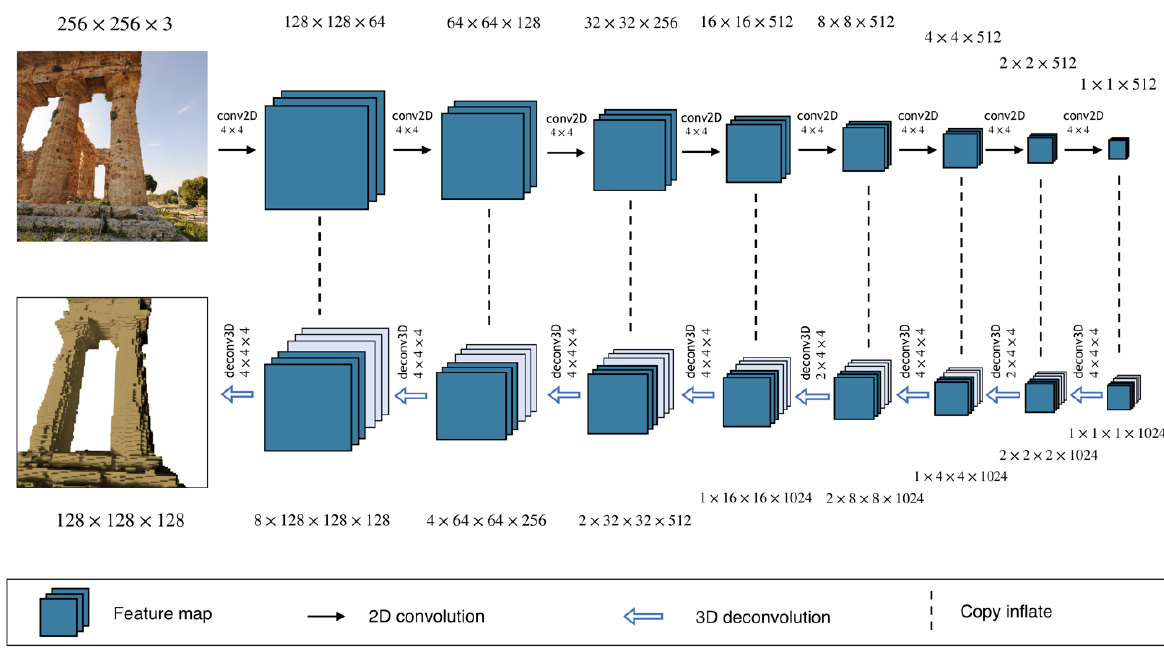
Figure 1: Overview of the Z-GAN generator network employed for 3D reconstruction from a single